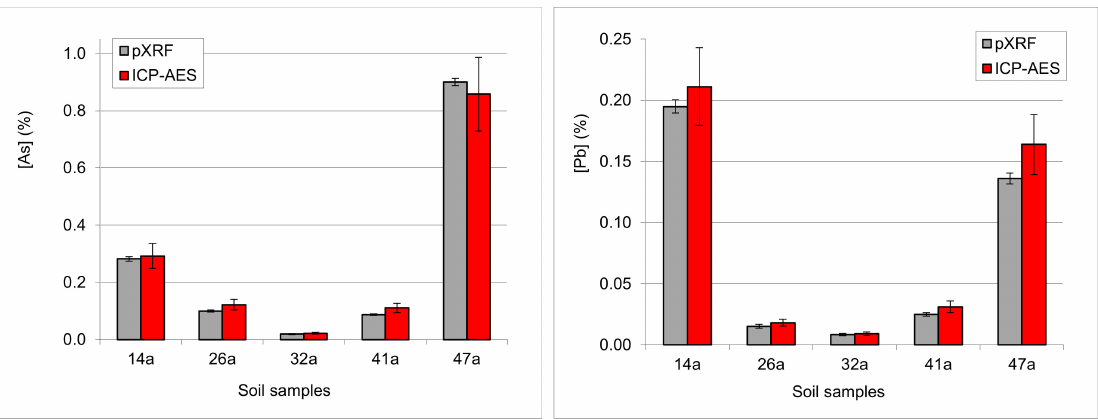
Figure 13. Pb-As interference, with As > Pb. As concentrations are correctly determined. When the As contents is lower than the Pb contents (Pb/As ratio >10), the As contents is either not quantified or overestimated (Figure